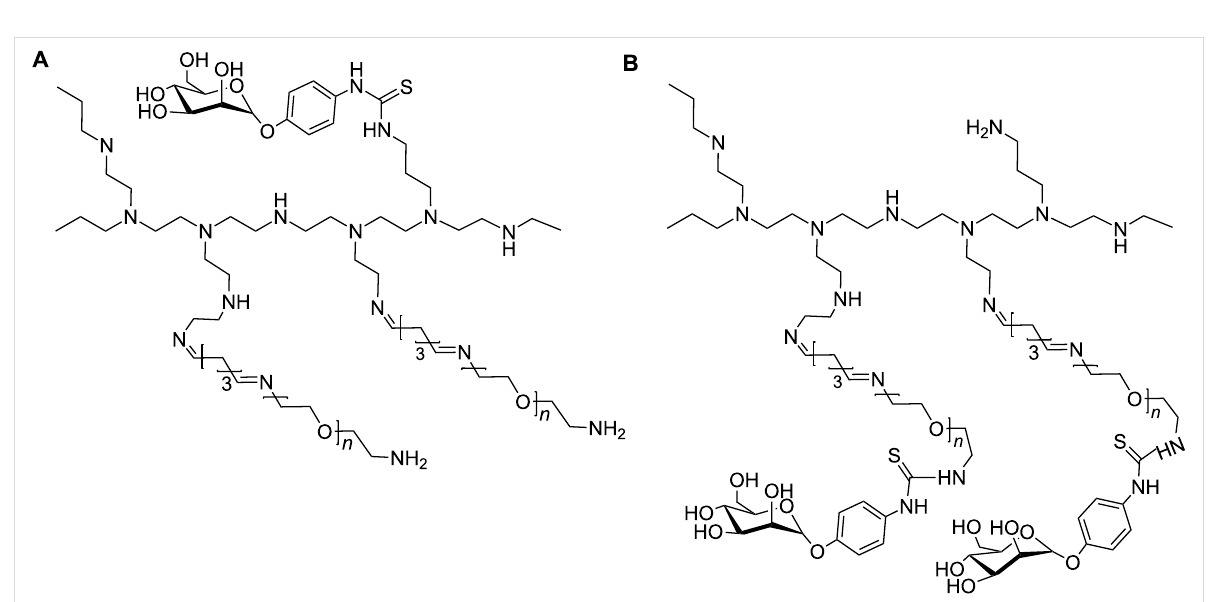
Figure 3: Mannosyl PEGylated polyethylenimine for delivery systems. (A) Mannose and PEG are independently linked to the PEI backbone; (B) Mannose is attached to PEI via a PEG chain, adapted from